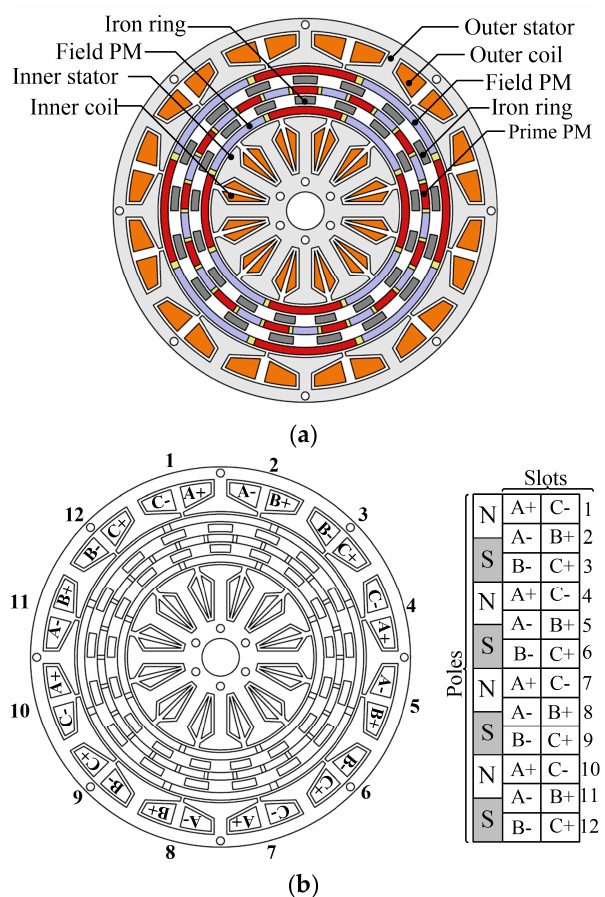
Figure 1. Structure of double-stator permanent magnet generator integrated with a magnetic gear: ( a ) Two dimensional model view of structure; ( b ) Winding diagram. Table 1. Design specifications of the proposed machine.